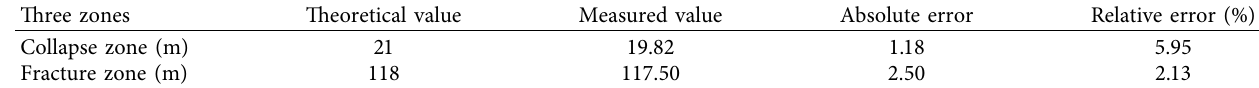
Table 3: Table of analysis of overburden three